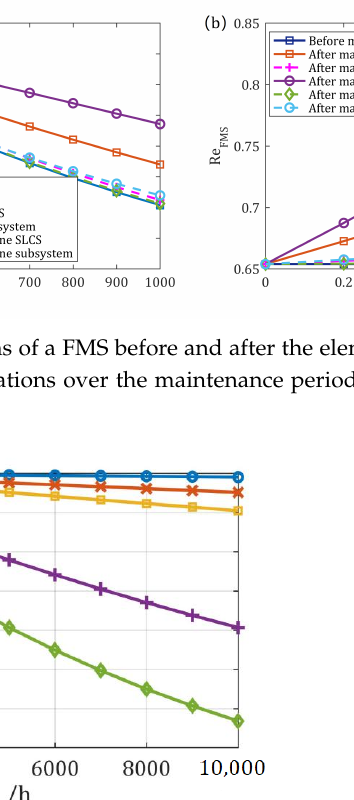
Figure 8. Variations of element reliability over the actual running time under different failure